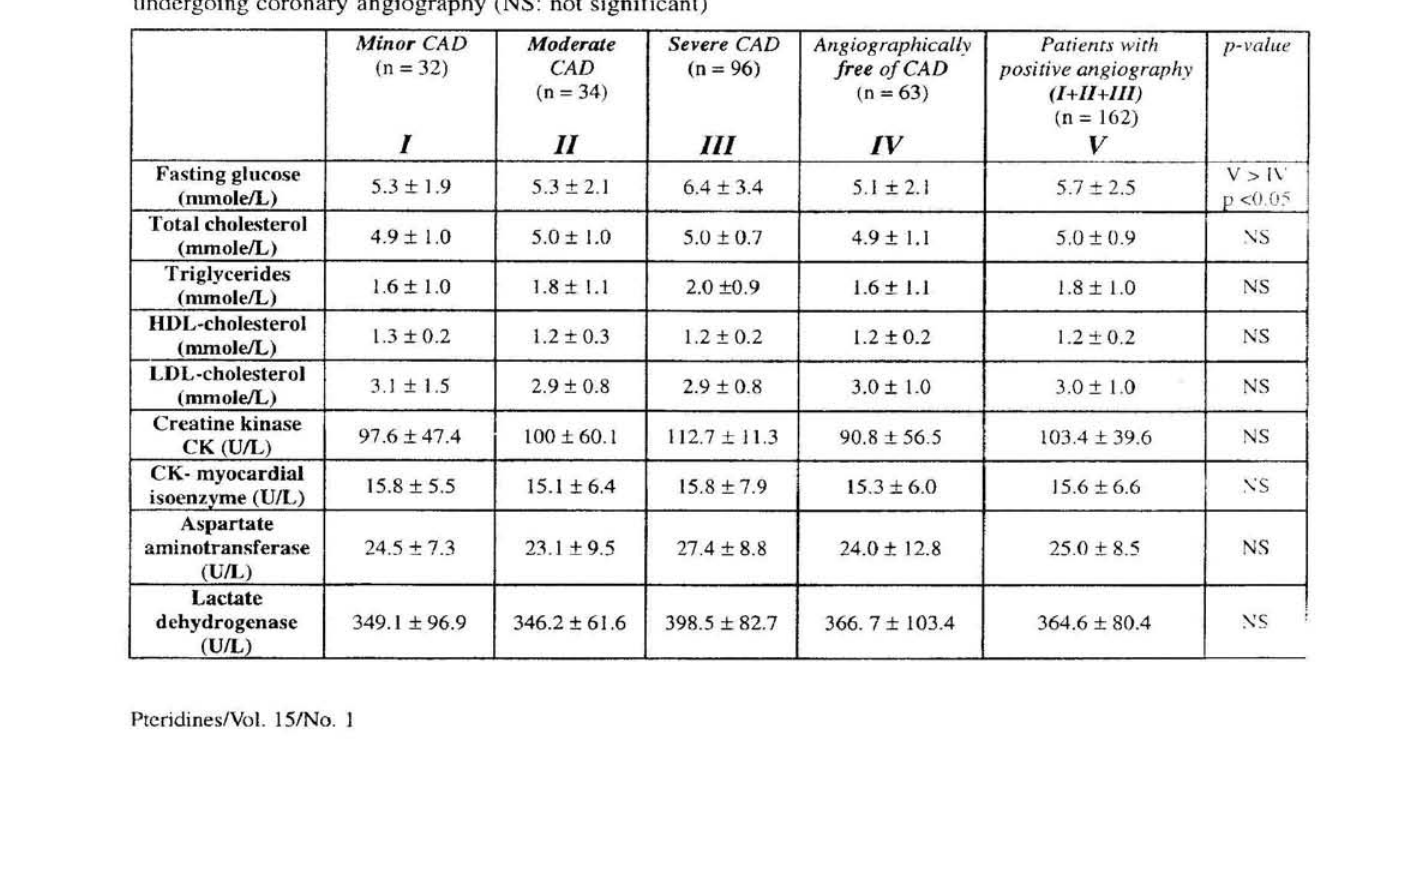
Table 2. Serum glucose, lipid data and cardiac cnzyme activities in patients with coronary artery discasc (CAD) undergoing coronary angiography (NS: not significant) Minor